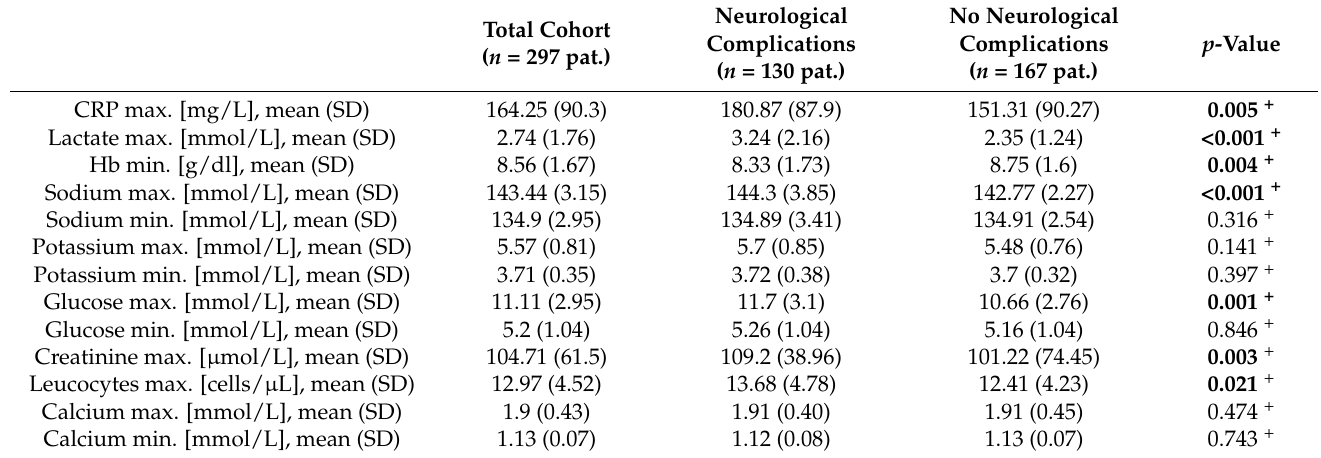
Table A1. Postoperative biochemical markers in patients with or without neurological complications. Total